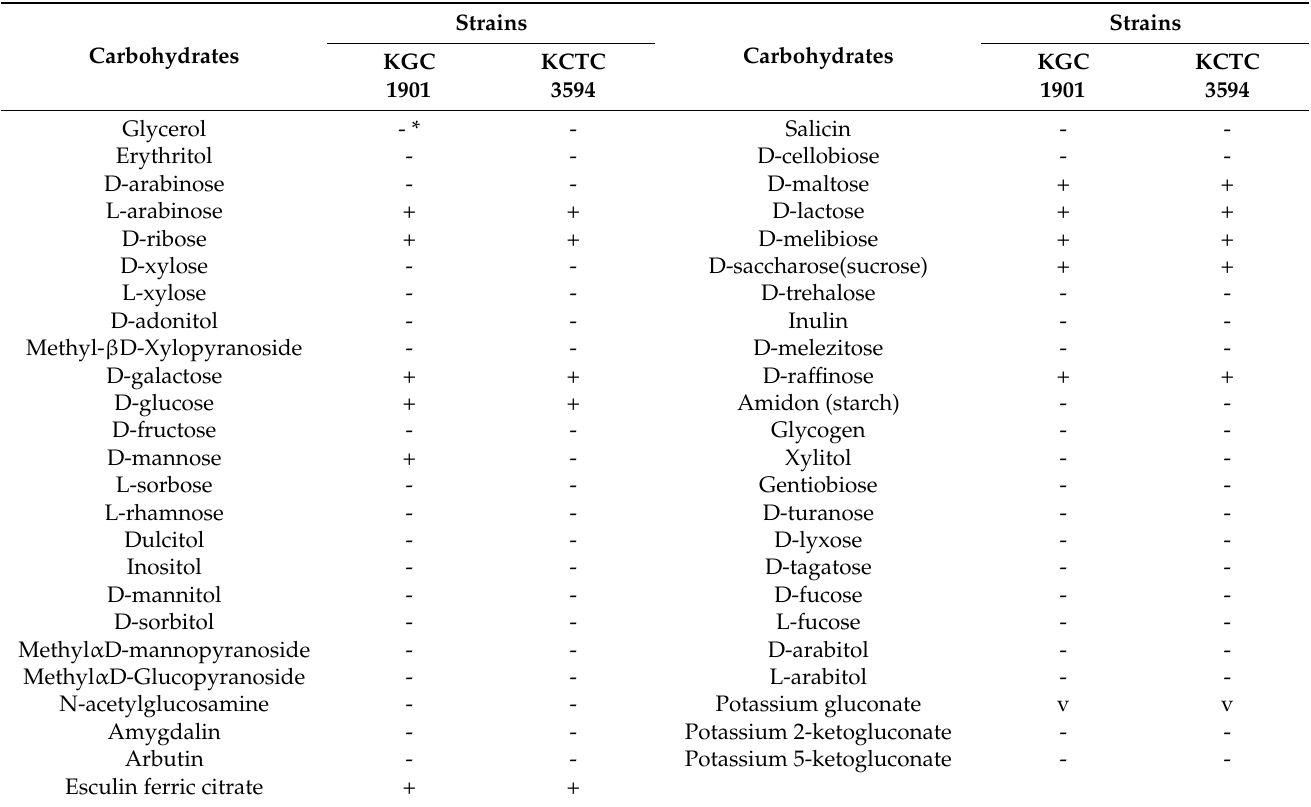
Table 2. Carbohydrate fermentation of L. reuteri KGC1901.